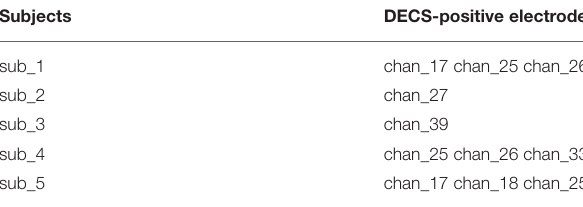
TABLE 3 | DECS-positive electrodes of each subject.